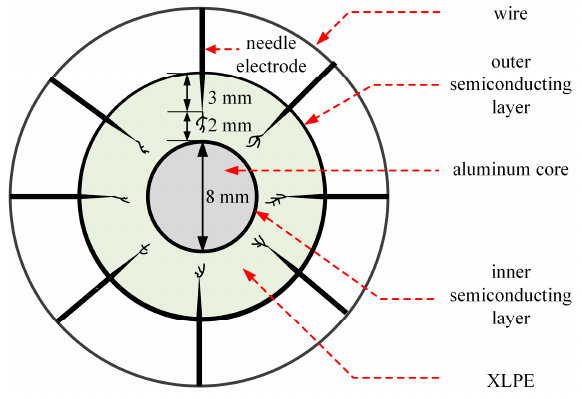
Figure 1. The structure of the sliced cable